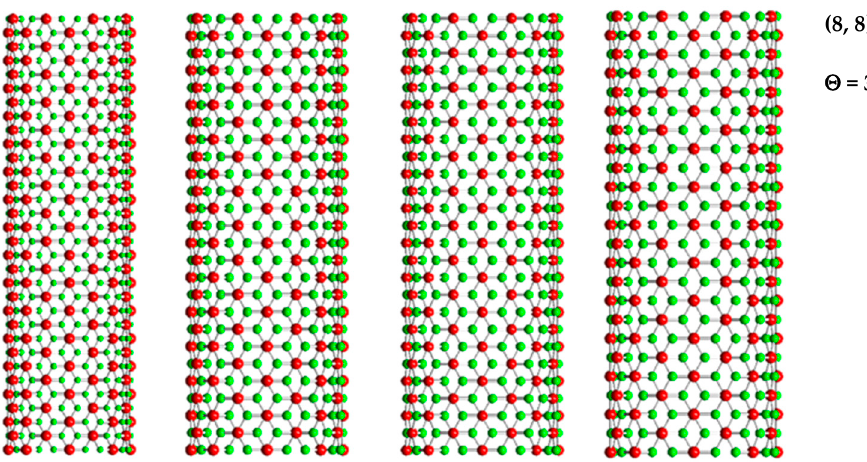
Figure 2. Configurations of (14, 0) zigzag, (12, 6) chiral and (8, 8) armchair of SWBPNTs, SWAlPNTs, SWGaPNTs and SWInPNTs, obtained using the software Nanotube Modeler©. P atoms are in green; B, Al, Ga and In atoms are in red.